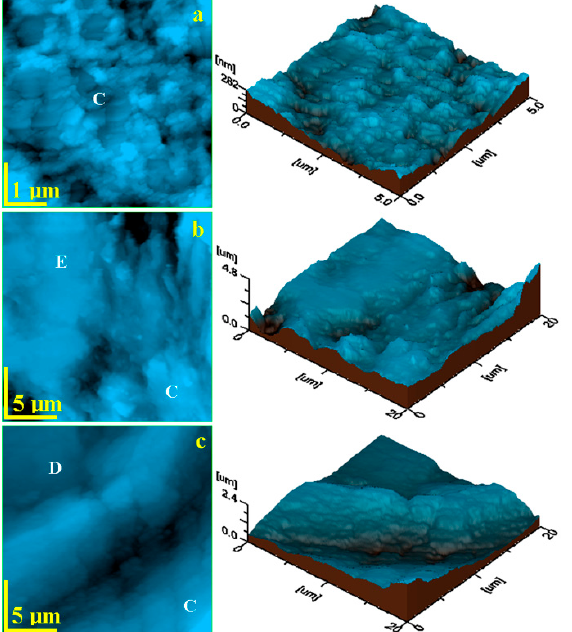
Figure 3. AFM 2D topographic images for Group A samples: ( a ) composite (restorative material), ( b ) composite—enamel interface, and ( c ) composite—dentin interface. Tri-dimensional images are given next to 2D topographic images. C-composite, E-enamel, D-dentin.